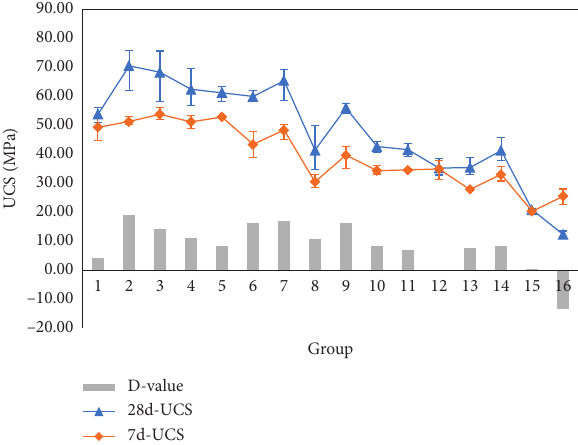
Figure 3: Strength of green fly ash-based grouting